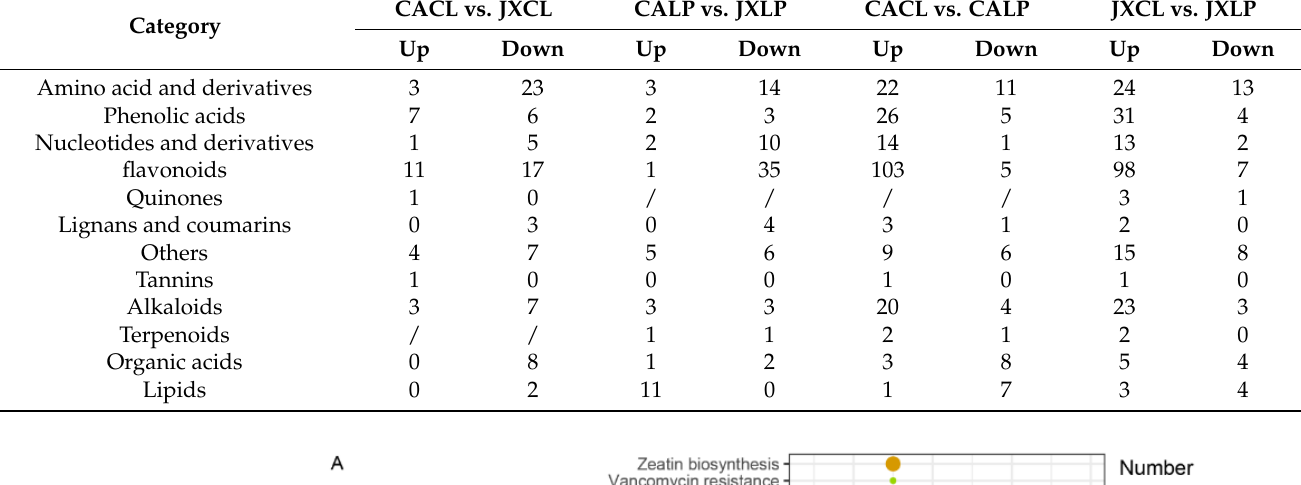
Table 1. Number of differentially accumulated metabolites in different categories in CL and LP of two cultivars “CA” and “JX”. “CA”, China Antique; “JX”, JianXuan-17; CL, cotyledon; LP; lotus plumule.